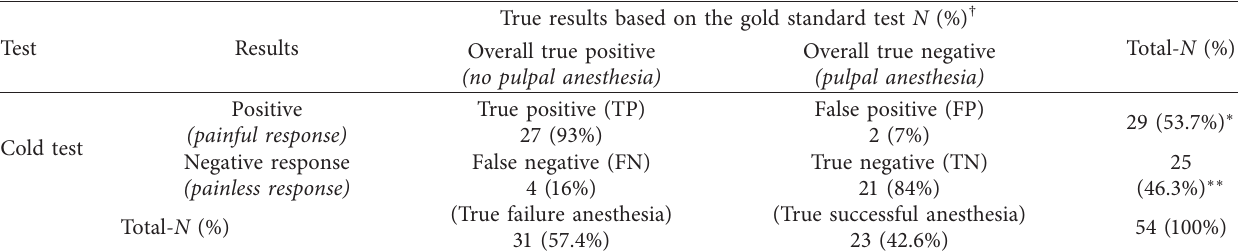
Table 4: Number and percentages of patients with true/false positive and negative responses to the postanesthetic cold test versus the gold standard test.